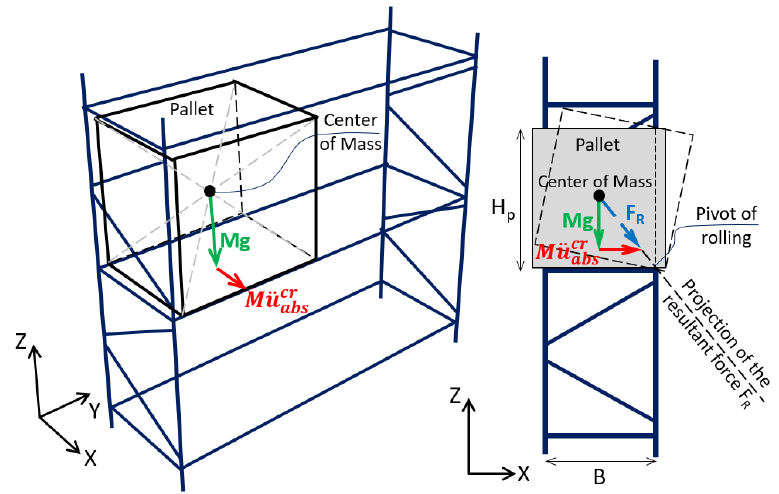
Figure 11. Explanatory illustration of the concept of critical absolute acceleration.